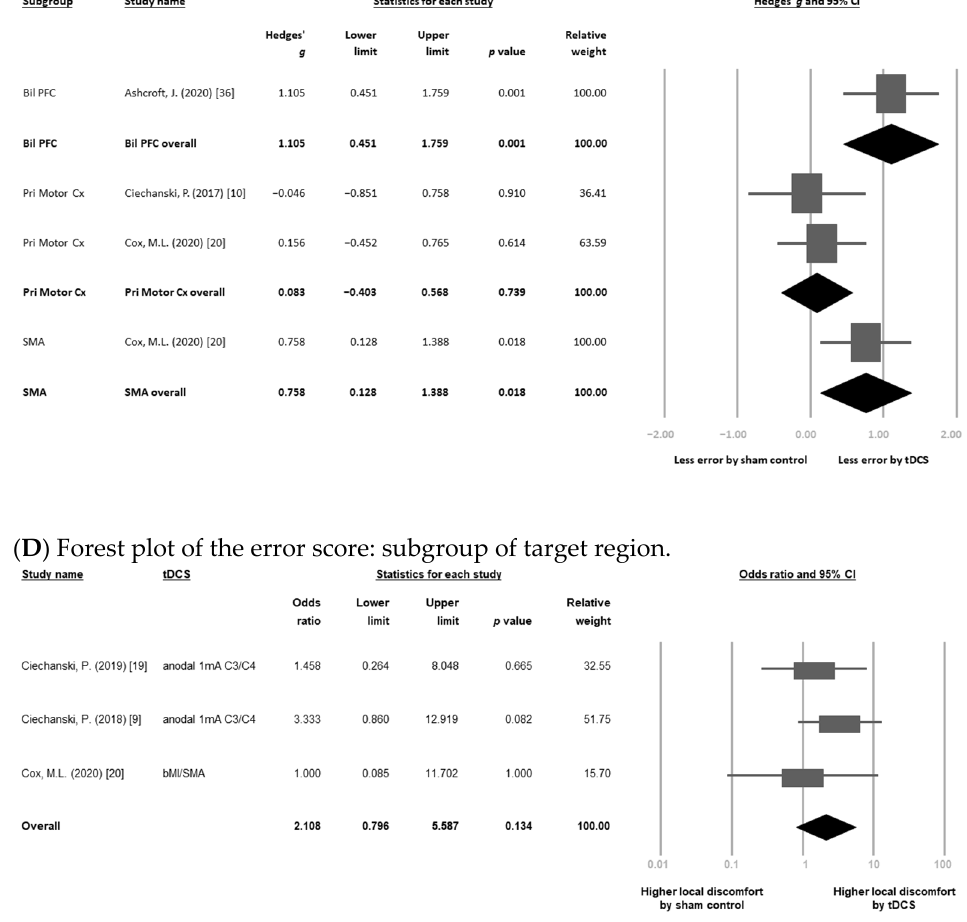
( E ) Forest plot of the safety profile: rate of local discomfort. Figure 2. Forest plots of ( A ) the primary outcome: surgical performance; ( B ) surgical performance: subgroup of target region; ( C ) the secondary outcome: error score; ( D ) error score: subgroup of target region; and ( E ) the safety profile: rate of local discomfort. The bold rows were the overall statistical results of each subgroups.